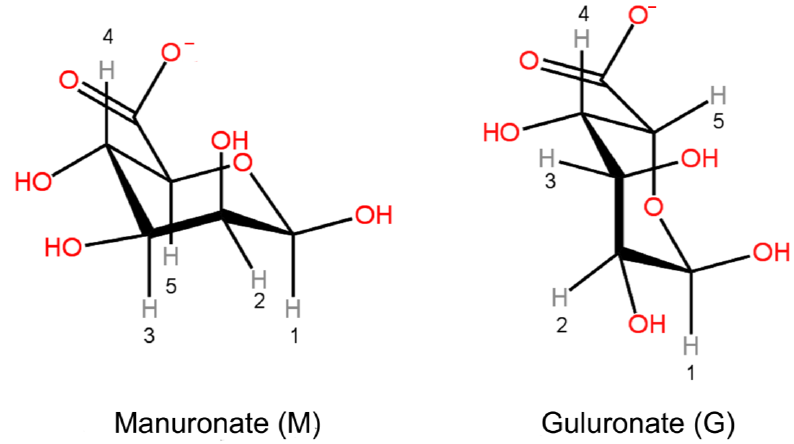
Figure 1. Manuronate and guluronate residues structural formulas.